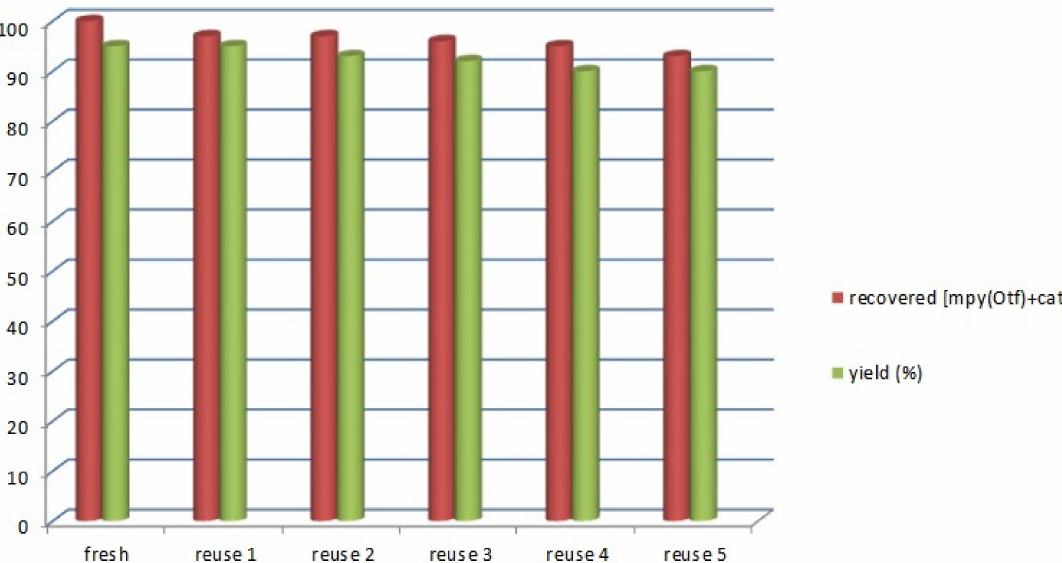
Figure 3. Recovery and re-use of catalytic IL/FeCl 3 system until six